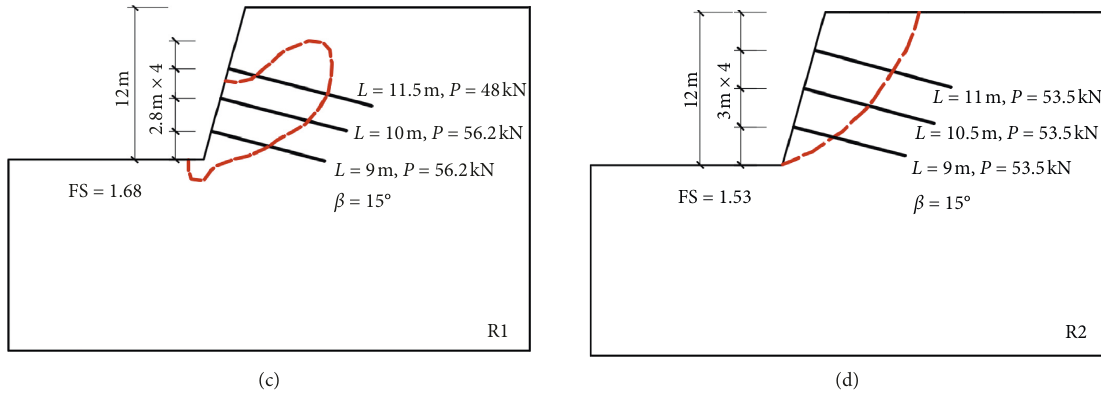
Figure 13: Design and comparison of reinforcement scheme at 75 ° slope. (a) The contour map of DRD for 75 ° slopes, (b) the azimuth of Δ σ for 75 ° slopes, (c) reinforcement design of quantitative reinforcement analysis, and (d) reinforcement design of Bishop’s simplified method.